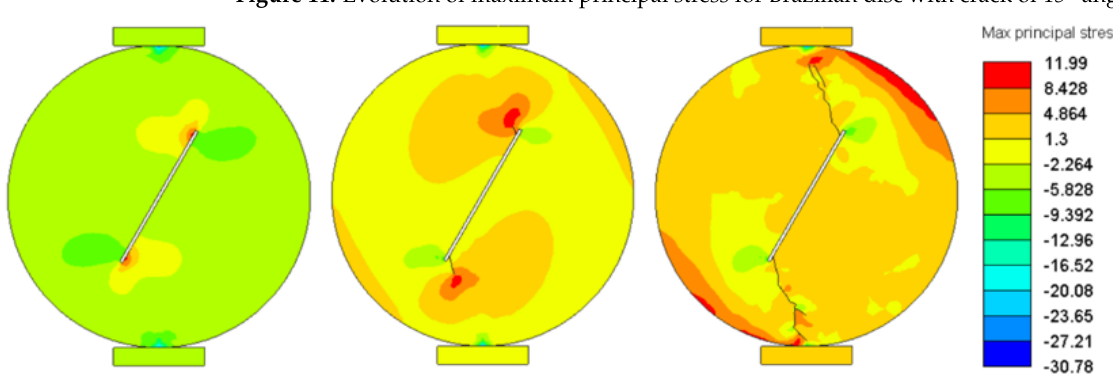
Figure 12. Evolution of maximum principal stress for Brazilian disc with crack of 30° angle.